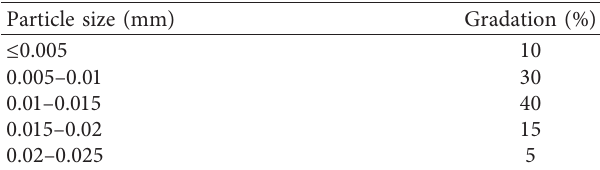
Table 2: The particle size of the silty